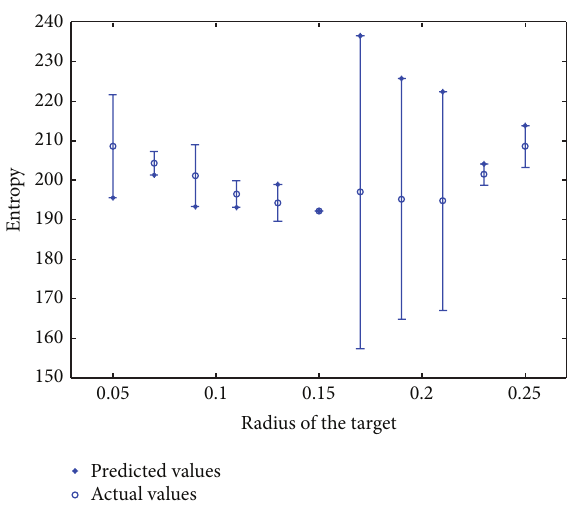
Figure 7: The errorbar of the entropy of the images with the actual and estimated wall parameters.